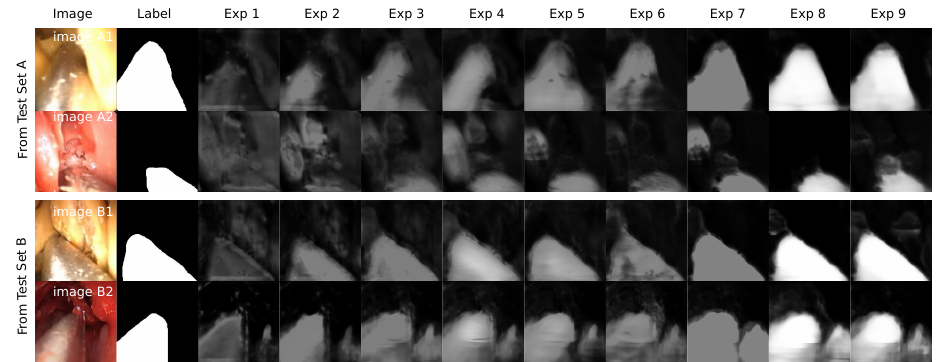
Figure 10. Sample predictions from Test Set A and Test Set B in Exp. 1–9. The prediction confidence is greater in later experiments. Images A1 and A2 show poor results in early experiments. Image B2 demonstrates a phantom 2nd tool falsely detected from Exp. 7